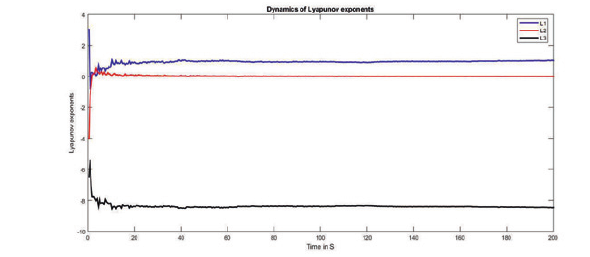
Fig. 3: Dynamics of Lyapunov Exponents.